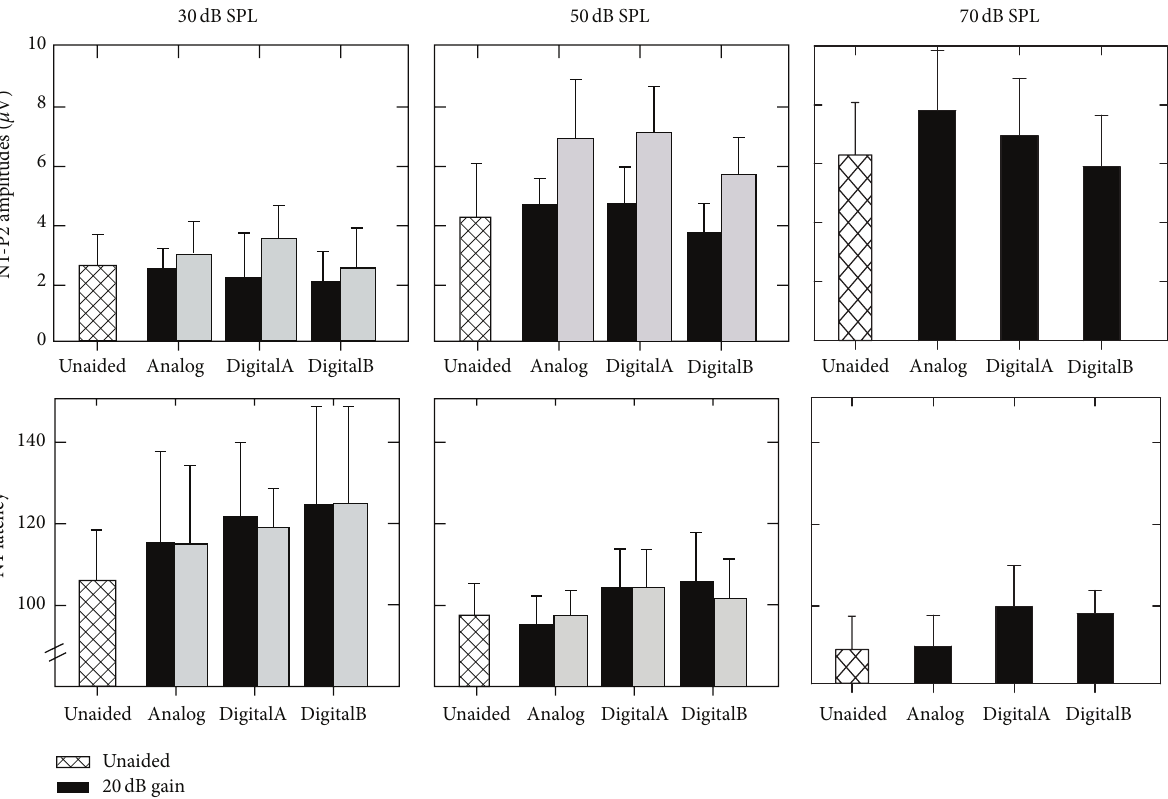
Figure 2: Mean and SD amplitude and latency data for unaided and aided conditions (Analog, DigitalA, and DigitalB) with two gain settings (20 and 40dB) at three input levels (30, 50, and 70 dBSPL). Reprinted from L. M. Jenstad et